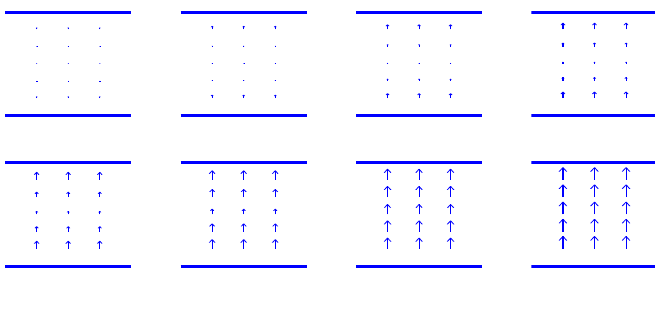
Figure 2. Displacement of the electric field E during the charge of a capacitor. The divergence of E remains different from zero, until the process is terminated.